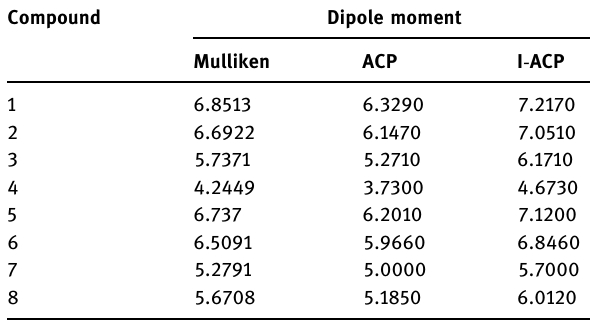
Table 3: Computed molecular dipole moments ( in Debye ) for